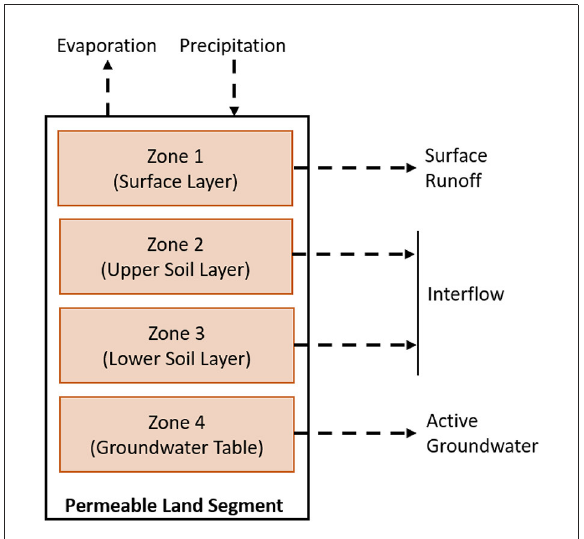
FIGURE2 The zones that compose the element type, Permeable Land Segment, and the movement of the constituent (water) through the